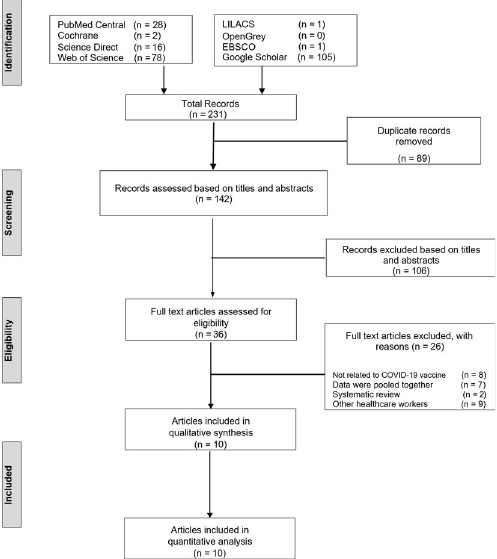
Fig 1. PRISMA flowchart. Study selection and reasons for study exclusion according to the PRISMA guidelines.